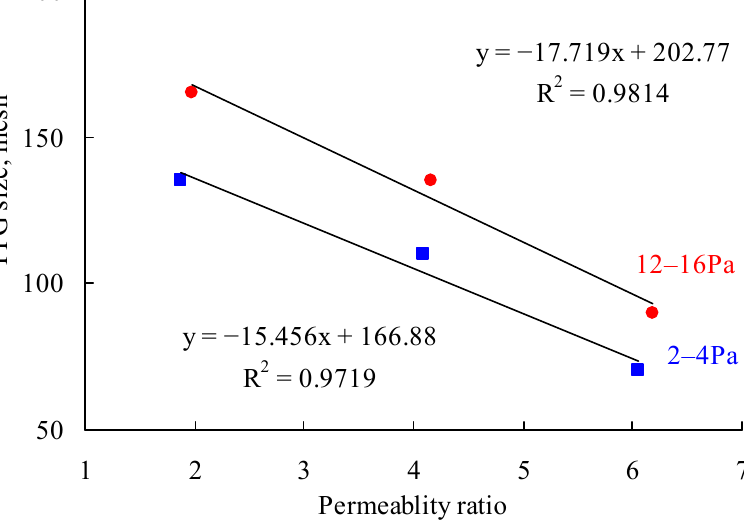
Figure 7. Fractional flow of parallel sand packs with permeability ratio of about 2 after injecting the PPG (12–16 Pa). ( a ) 100–120 mesh; ( b ) 120–150 mesh; ( c ) 150–180 mesh; ( d ) profile improvement index.